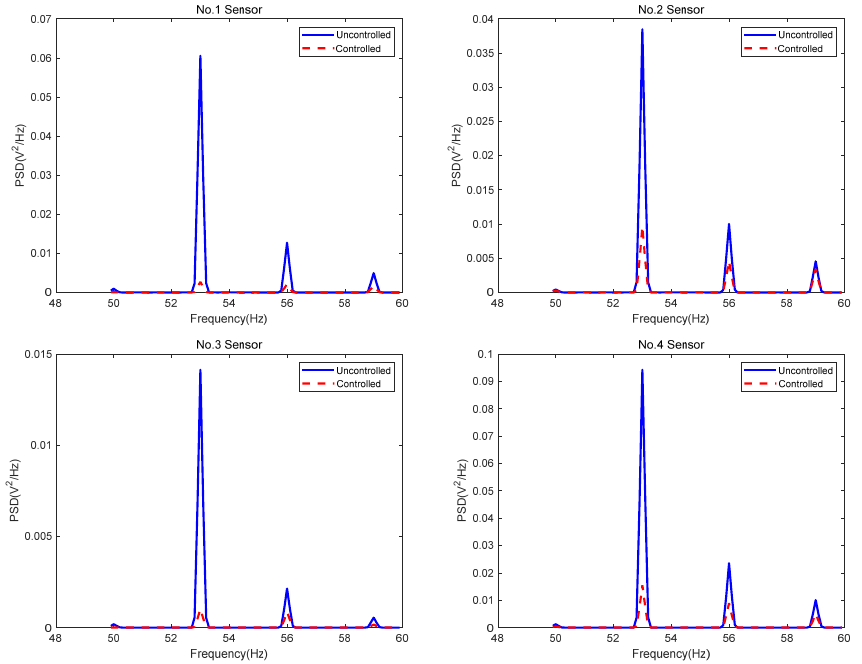
Figure 17. PSDs of sensor signals obtained by experiments. Table 5. RMS values of sensor signals: Experiment #2.